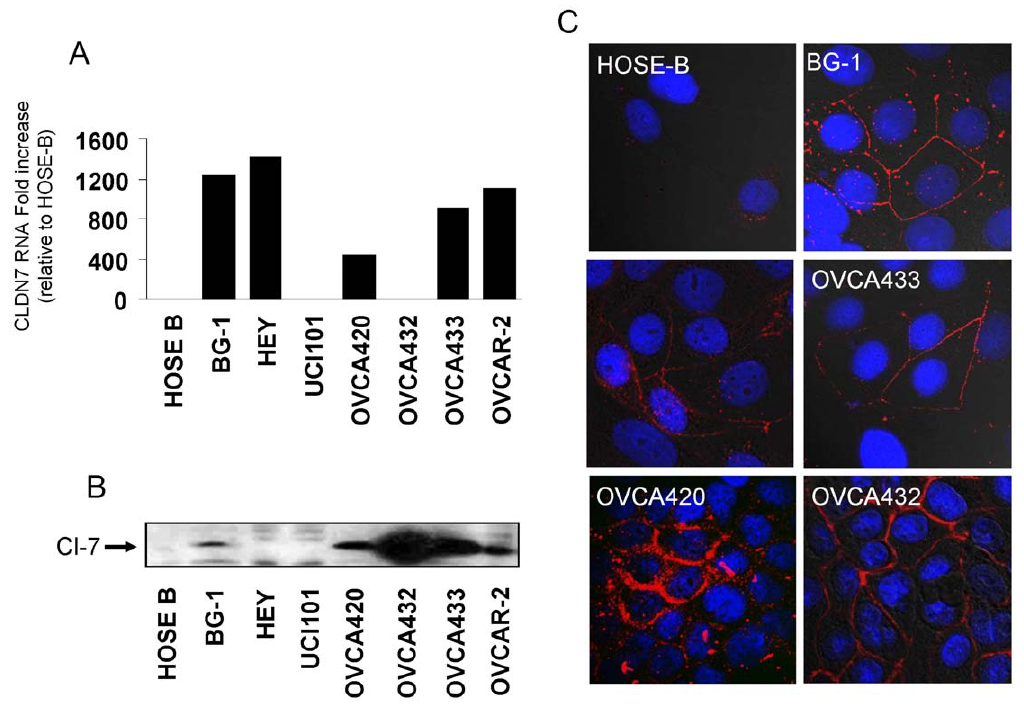
Figure 2. CLDN7 expression in ovarian cancer cell lines. A. Claudin-7 immunoblotting reveals high levels of expression in the indicated ovarian cancer cell lines. B. RT-PCR analysis of CLDN7 mRNA in cell lines. C. Immunofluorescence of selected cancer cell lines shows strong claudin-7 expression at the cell junction in BG-1, OVCA433, OVCA420 and OVCA432, as well as punctuate cytoplasmic staining in BG-1 and OVCA420. Claudin-7 was detected with an anti-claudin-7 antibody and visualized with secondary antibody conjugated to Alexa fluor. Nuclei of cells were counterstained with DAPI. Images were merged to determine correct localization.